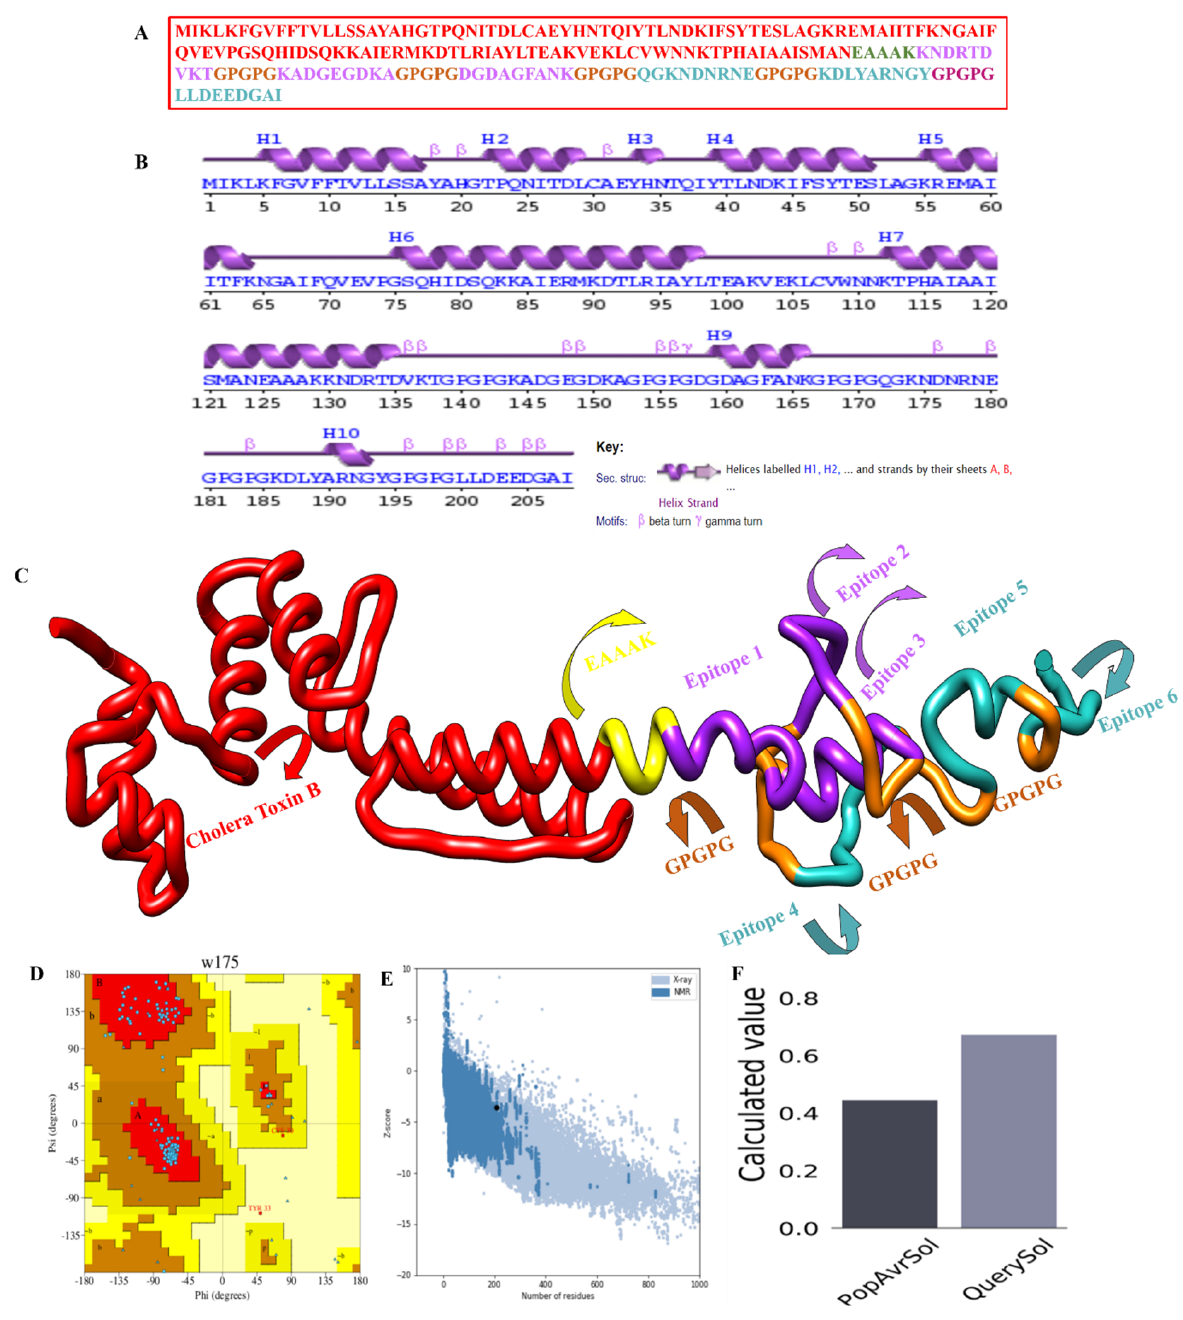
Figure 6. Structural classification of the multi-epitope-based peptide vaccine construct: ( A ) polyepitope vaccine construct sequence, ( B ) secondary structure for the MEBEPV, (C) Tertiary structure for the MEBEPV, ( D ) Ramachandran plot of the selected model, ( E ) ProSA-web results presenting the Z-score, and ( F ) solubility graph.